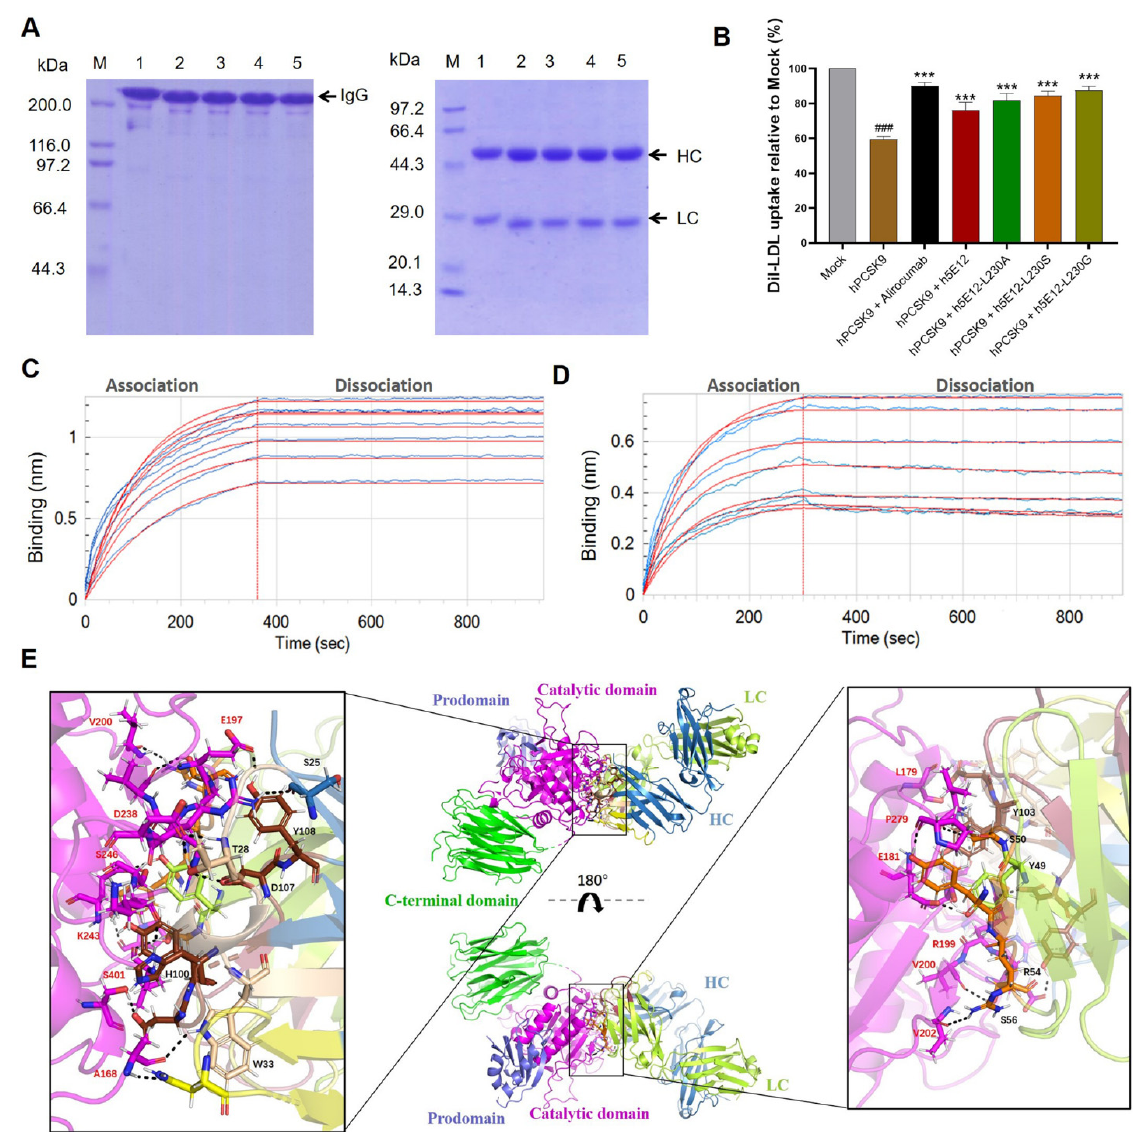
Figure 6. Preparation and identification of the full-length anti-PCSK9 antibodies. ( A ) SDS-PAGE analysis of purified anti-PCSK9 mAbs under non-reducing (left panel, 10% gel) and reducing (right panel, 12% gel) conditions. M, molecular weight marker; Lane 1, Alirocumab; Lane 2, h5E12; Lane 3, h5E12-L230A; Lane 4, h5E12-L230S; Lane 5, h5E12-L230G. ( B ) Effect of the anti-PCSK9 mAbs on PCSK9-mediated inhibition of LDL-C uptake in HepG2. ### p < 0.001 vs. Mock group; *** p < 0.001 vs. hPCSK9 group. Data are means ± SEM of 3 independent experiments. ( C , D ) Kinetics measurement of h5E12-L230G ( C ) and Alirocumab ( D ) binding to surface-immobilized antigen hPCSK9 using a ForteBio Octet QK e system. The biotinylated-hPCSK9 was loaded onto SA sensors and exposed to two-fold serial dilutions of antibody (800, 400, 200, 100, 50, 25, and 12.5 nM) solutions measure the association rate (k on ), and then moved to SD buffer (PBS, pH 7.4, 0.02% Tween 20, 0.1% BSA) without antibodies measure the dissociation rate (k off ). Blue and red lines show experimental and calculated fitting sensorgrams, respectively. Kinetic parameters were calculated by global fitting the binding curves (red lines) using Octet data Analysis software 7.1. ( E ) Intermolecular interaction analyses of the h5E12-L230G with hPCSK9. The prodomain, catalytic domain and C-terminal domain of hPCSK9 are colored in slate, magenta and green, respectively. The heavy chains’ variable regions are shown in skyblue and the light chains’ variable regions in limon. h5E12-L230G binds to the catalytic domain of PCSK9. Key residues involved in the interactions were represented as sticks models and labelled in red font for PCSK9 (cid:48) key residues, black for h5E12-L230G’ key